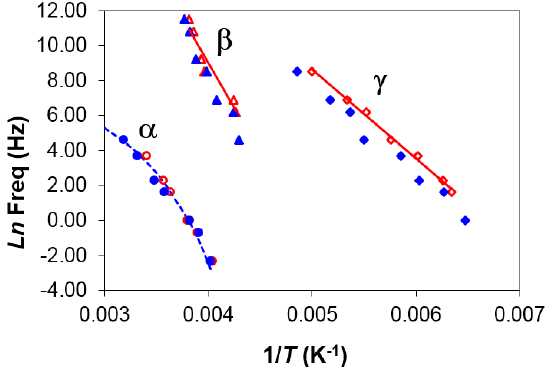
Figure 7. Relaxation map for PEI2000 at different heating rates: 0.5 °C/min (open symbols) and 2 °C/min (filled symbols).